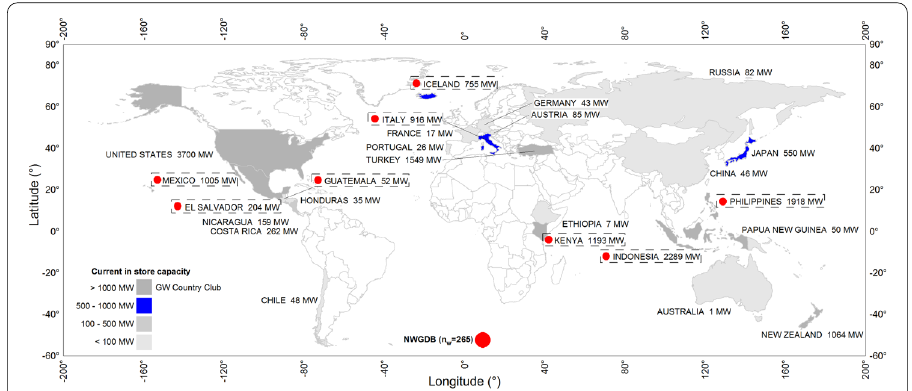
Fig. 3 Location of the worldwide geothermal fields used for the creation of the new Geochemical Database (NWGDB). The updated world geothermal power generation is also